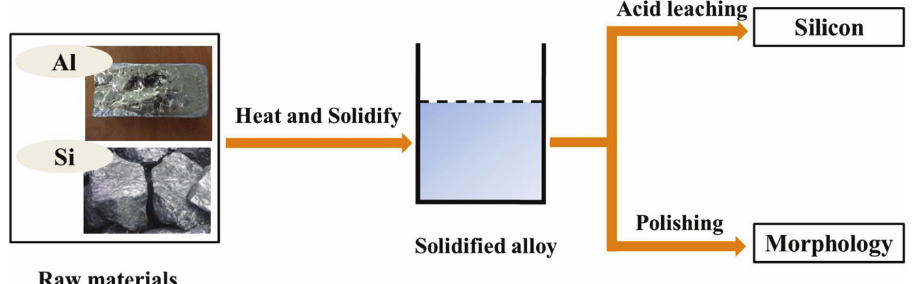
Figure 1: The schematic process of sample preparation and